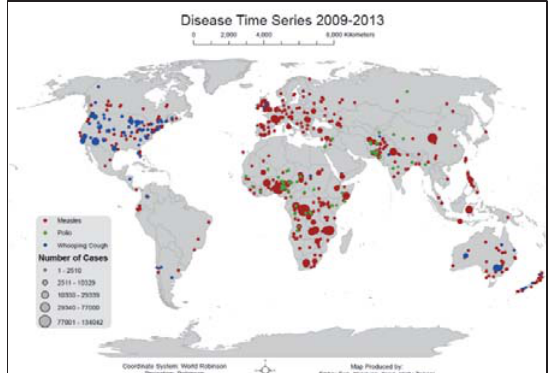
Figure 2. Spatio temporal analysis of measles, polio, and whooping cough